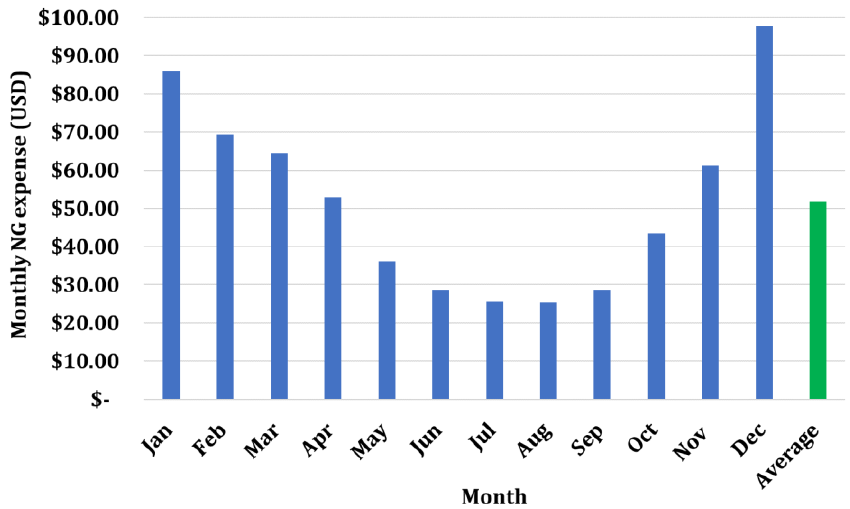
Figure 28. Monthly natural gas expense in Ontario to heat Greenhouse 1.